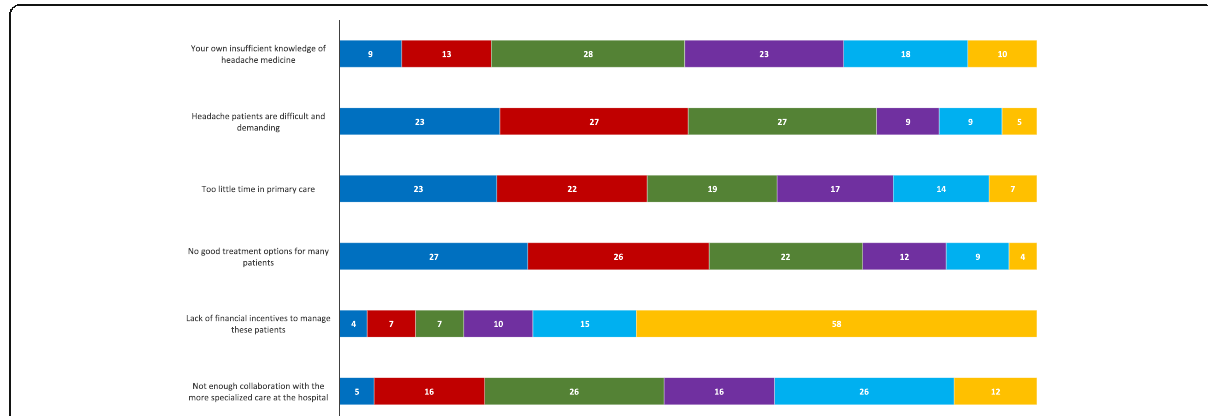
Fig. 4 GPs ’ ranking of the main barriers to optimised treatment and management of headache patients, scored on a scale of 1 – 6. The most important barrier is ranked from right to left as 1 (blue) and the least important as 6 (orange). The corresponding colours to score 2, 3, 4 and 5 are red, green, purple and turquoise, respectively. Numbers denote